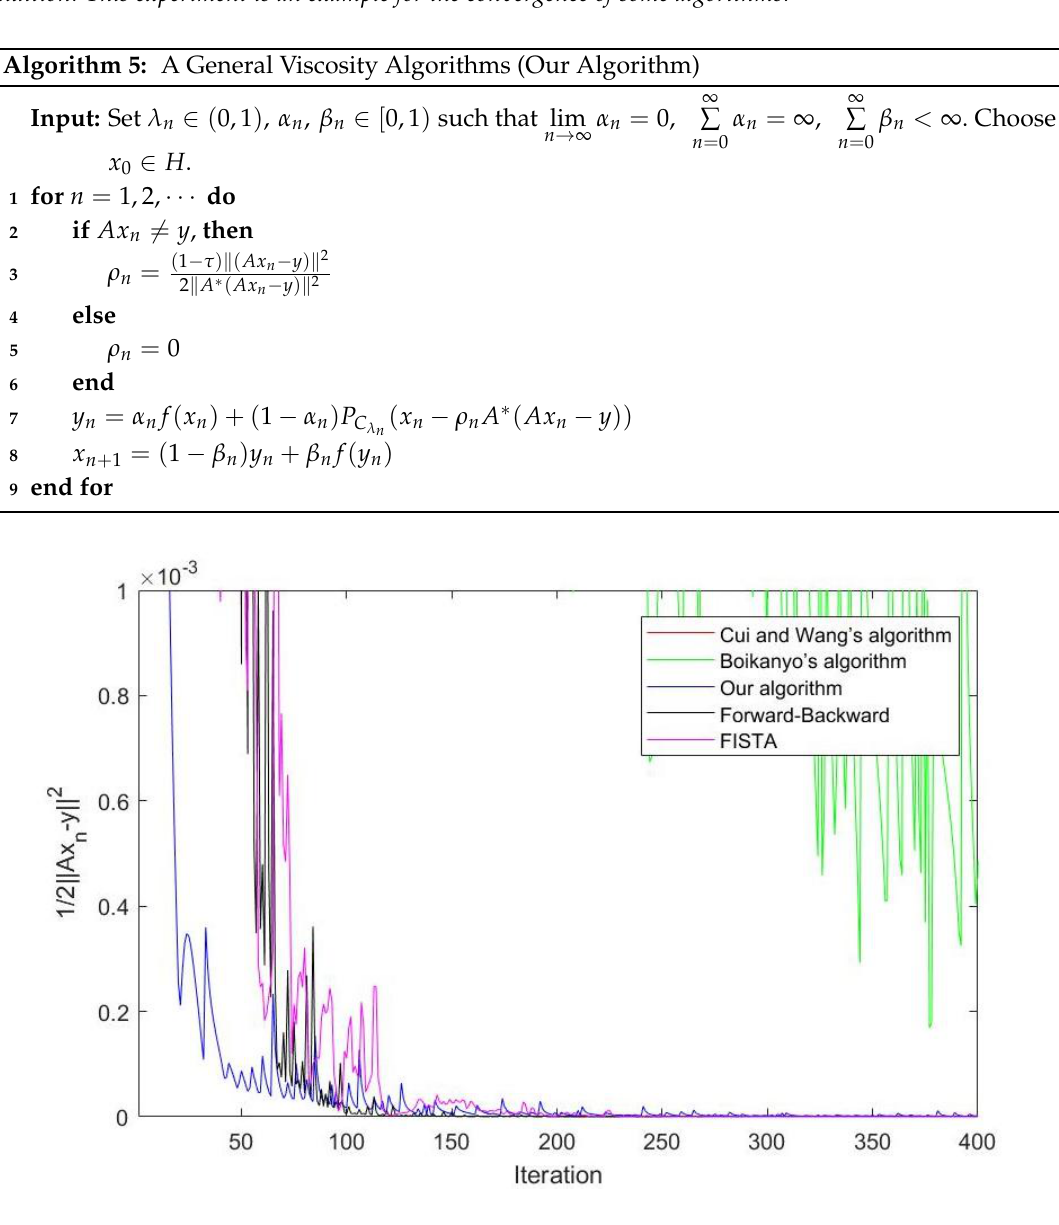
Figure 2. Case N = t = 10 and k =